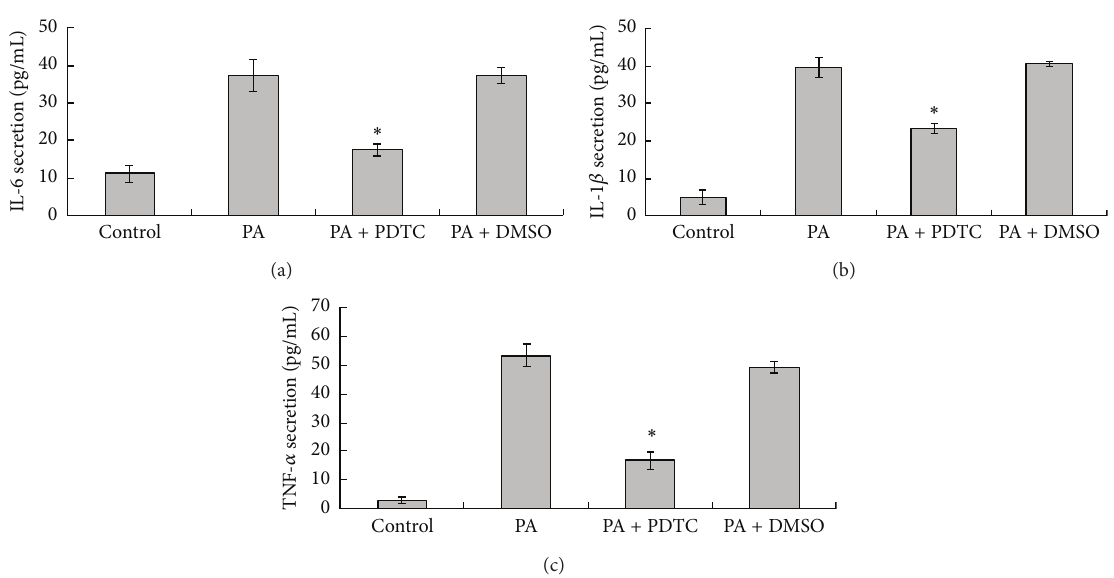
Figure 7: Effect of NF- 𝜅 B inhibitor PDTC on PA-induced IL-6, IL-1 𝛽 , and TNF- 𝛼 production. HaCaT cells were untreated or exposed to 0.15mM PA for 24 hours, either without or with pretreatment for 1 hour with 10 𝜇 mol/L PDTC or 0.1% dimethylsulfoxide (DMSO, as vehicle control). IL-6 (a), IL-1 𝛽 (b), and TNF- 𝛼 (c) productions were measured by ELISA. Each experiment was done in triplicate. Data are mean ± standard deviation. ∗ 𝑃 < 0.05 compared with